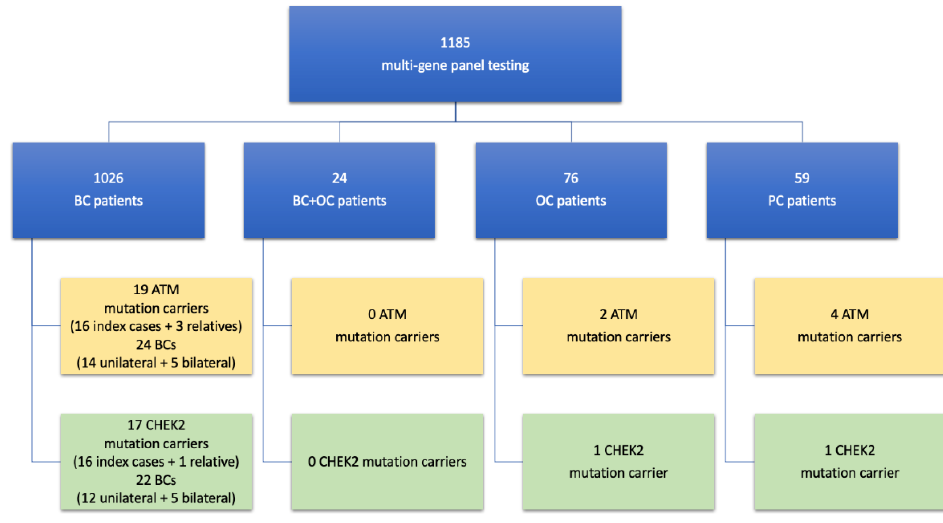
Figure 2. Study flow-chart.